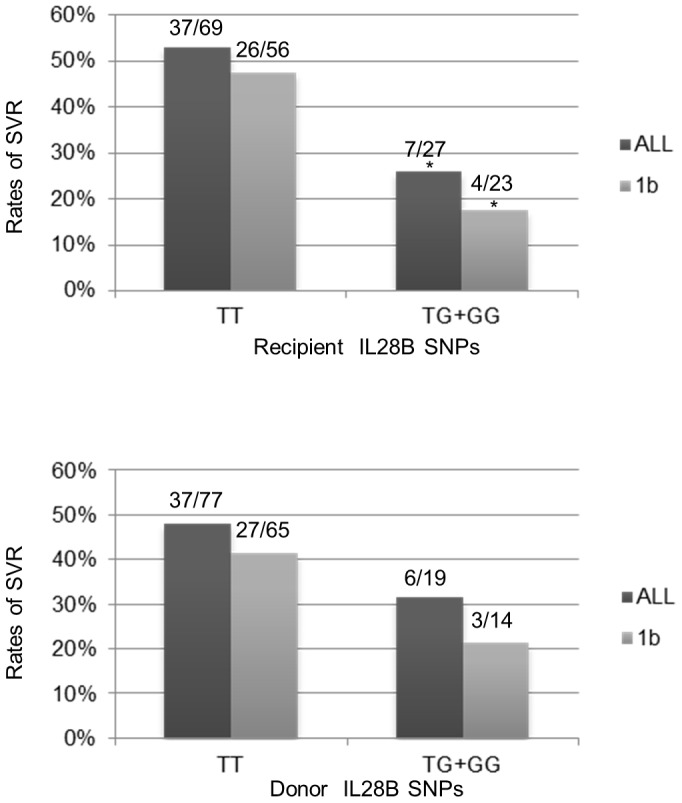
IL28B rs8099917 SNPs in the recipient and donor and corresponding rates of SVR.* indicates p = <0.05 v.s. major allele (TT) with corresponding background.